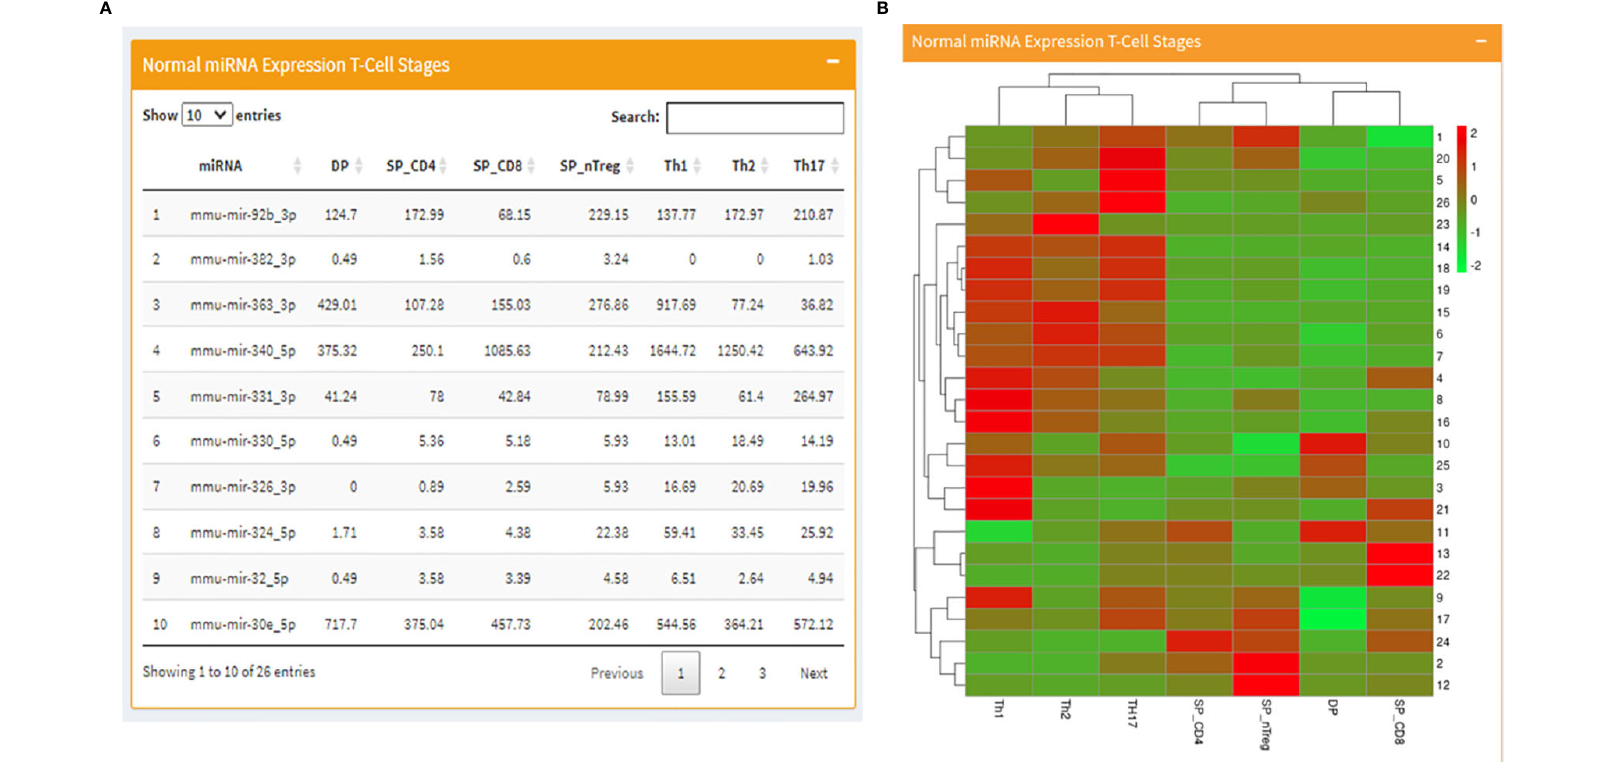
FIGURE 2 | Mouse page of the database where (A) displays a table with RAG1 miRNA expression across T cell developmental stages and (B) contains the corresponding